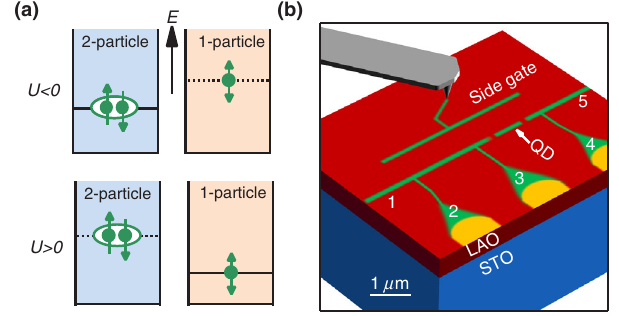
FIG. 1. Superconducting single electron transistor (SSET). (a) The excitation spectra of a QD depends on the sign of the interaction strength U . When U < 0 (top two panels), the two- electron ground state (top left-hand panel) is lower than the one- electron ground state. When U > 0 (bottom two panels), the one-electron ground state is lowest (bottom right-hand panel). (b) Electron-electron interactions are probed by a SSET fabri- cated by c-AFM lithography. The nanowire QD is defined by two barriers between leads 3 and 4 separated by 1 μ m. A side gate tunes the chemical potential of the